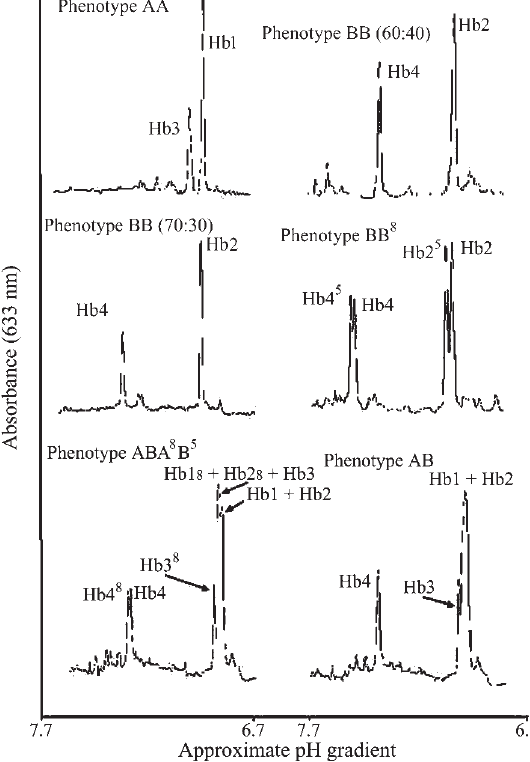
Figure 2 - Representative hemoglobin phenotypes, shown as densito- metric scans of ultrathin polyacrylamide gels after isoelectric focusing over 1 pH unit